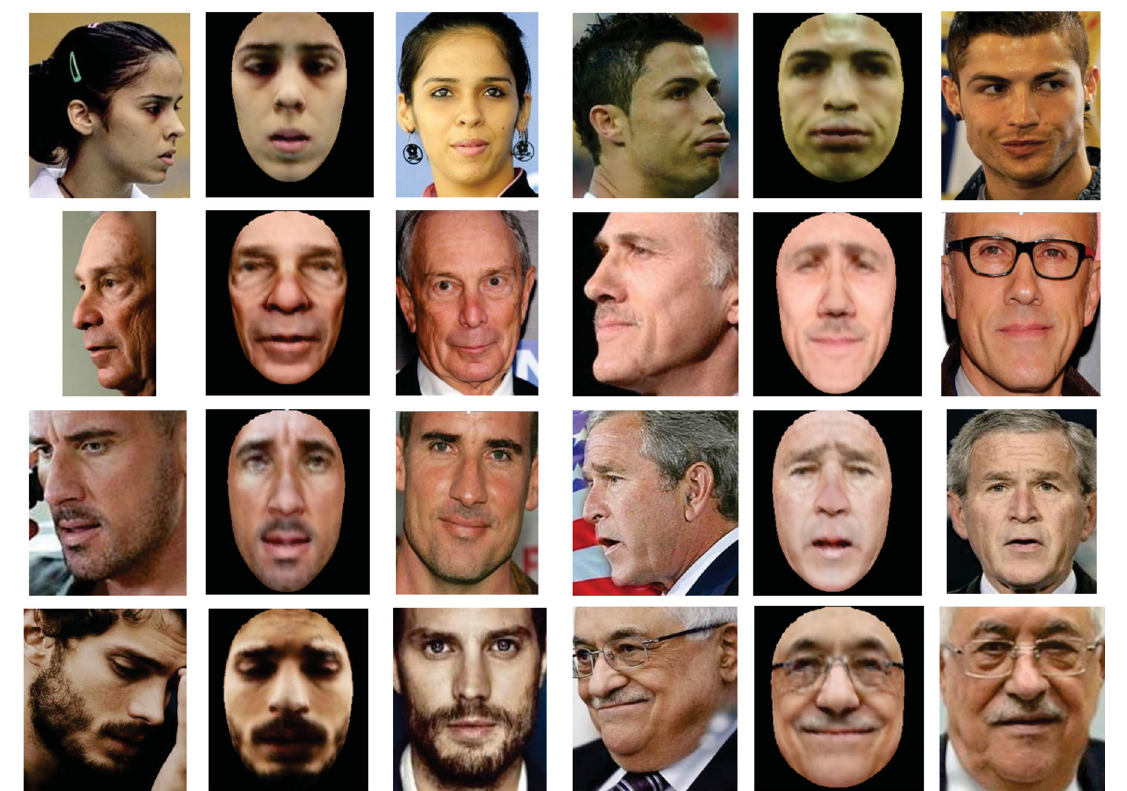
Fig. 6 Frontalization results on the CFP dataset. In each triple, left-to-right: face profile, frontalized face, actual frontal face from CFP.